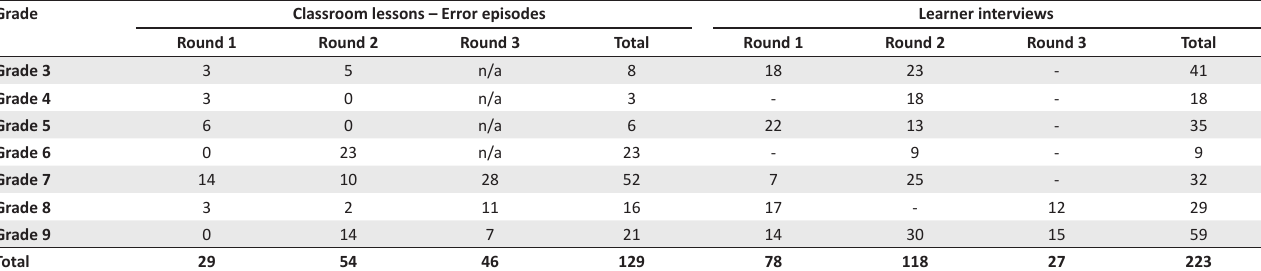
TABLE 1: Overall time coded